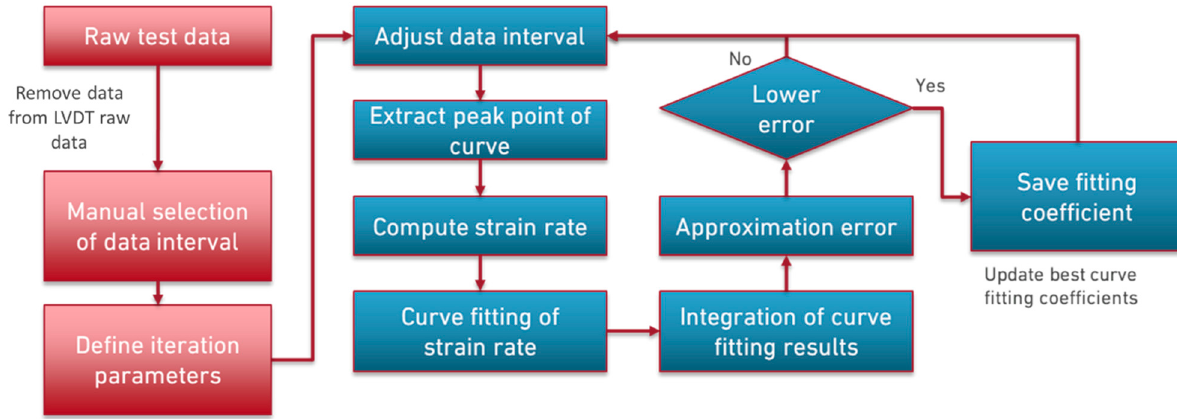
Figure 7. Flowchart of the cyclic creep